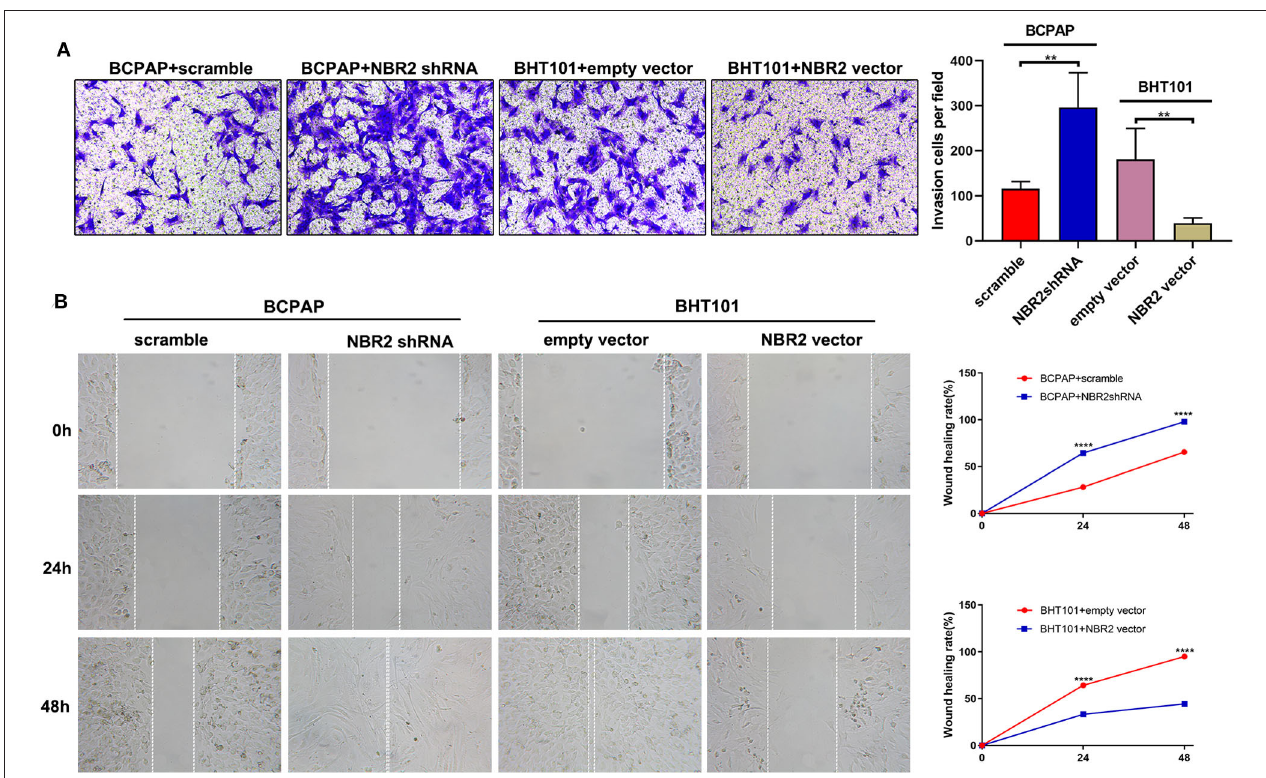
FIGURE 3 | Altered NBR2 expression modulates the invasion and wound healing of TC cells. (A) Transwell analysis of cell invasion. (B) Wound healing analysis. Data are expressed as the mean ± SD of each group of cells from three separate experiments. ** P < 0.01; **** P <